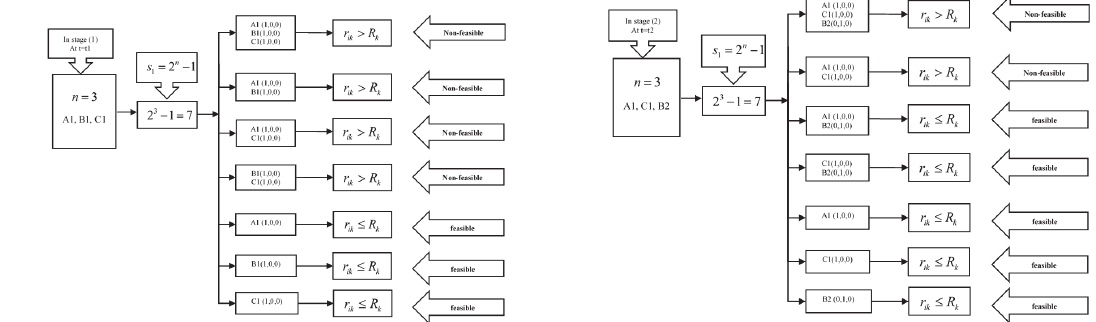
Fig. 4a. The ways to execute project activities at stage (1) Fig. 4b. The ways to execute project activities at stage (2)